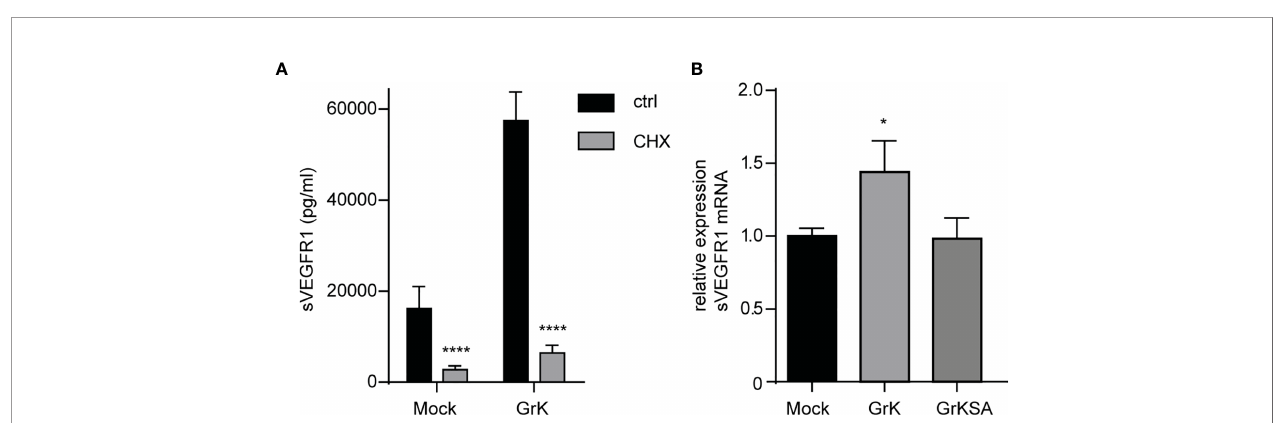
FIGURE 5 | GrK potentiates de novo VEGFR1 mRNA and protein expression. (A) HUVECs were pre-treated with cycloheximide (CHX) to inhibit protein translation and subsequently treated for 24 hours with 500nM GrK or GrKSA. sVEGFR1 levels in the medium were measured by Luminex. (B) HUVECs were treated for 16 hours with 500nM GrK or 500nM GrKSA and sVEGFR1 mRNA expression was measured in a RT-qPCR assay. Results are depicted as mean ± SEM, n ≥ 3. *P < 0.05; ****P < 0.0001, compared to Mock